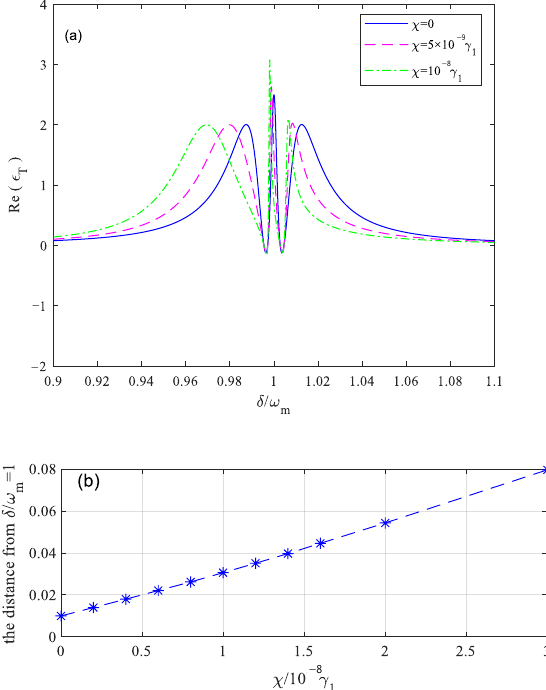
Figure 4. ( a ) The real part of the output field as a function of the probe detuning 𝛿 − 𝜔 𝑚 for different Kerr coefficient 𝜒 , 𝜒 = 0 (black, solid curve); 𝜒 = 5 × 10 −9 𝛾 1 (pink, dashed curve); 𝜒 = 10 −8 𝛾 1 (green, dash-dotted curve); ( b ) The distance from 𝛿 as a function of the different Kerr 𝜔 𝑚 =1 coefficient 𝜒 . 𝛾 2 = 0.02𝛾 1 , and the other parameter values are the same as in Figure 3.